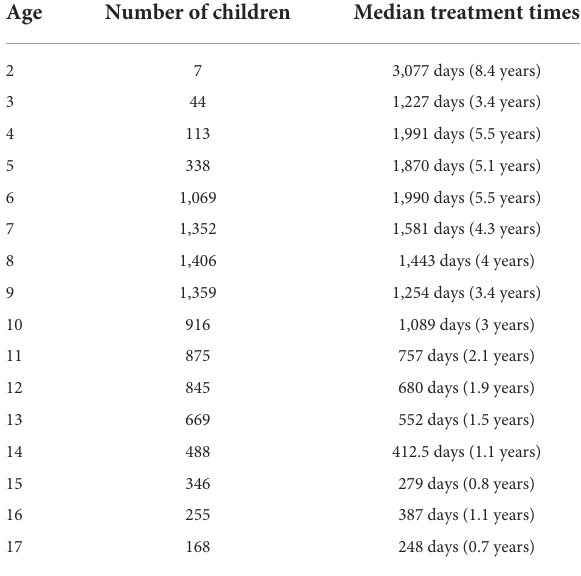
TABLE 4 Median durations of MPH treatment for patients with an initial prescription in 2011.